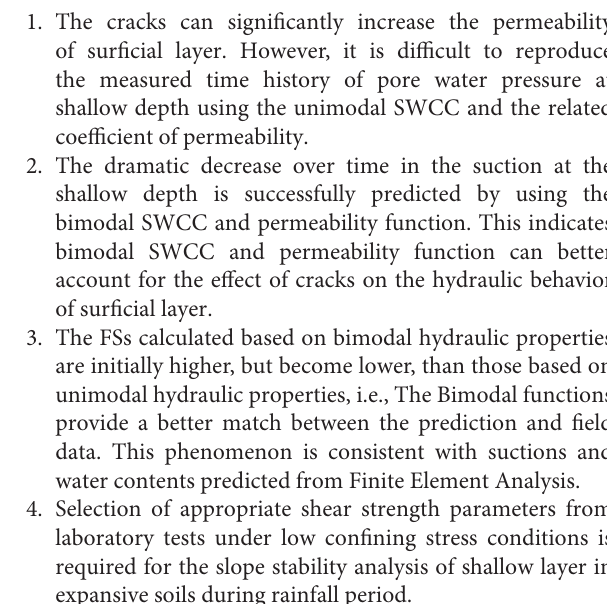
calculated FS are also compared with the previously obtained results in Figure 11 . At the end of rainfall period, the FSs